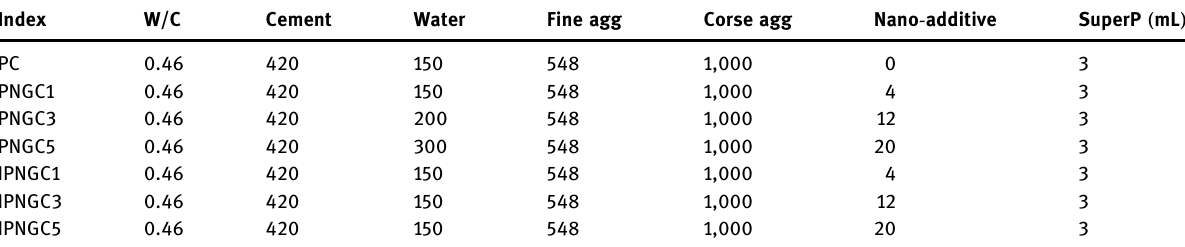
Table 1: Proportion of materials in the